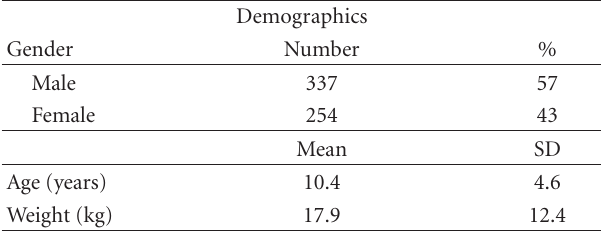
Table 1: Demographic and other patient data.